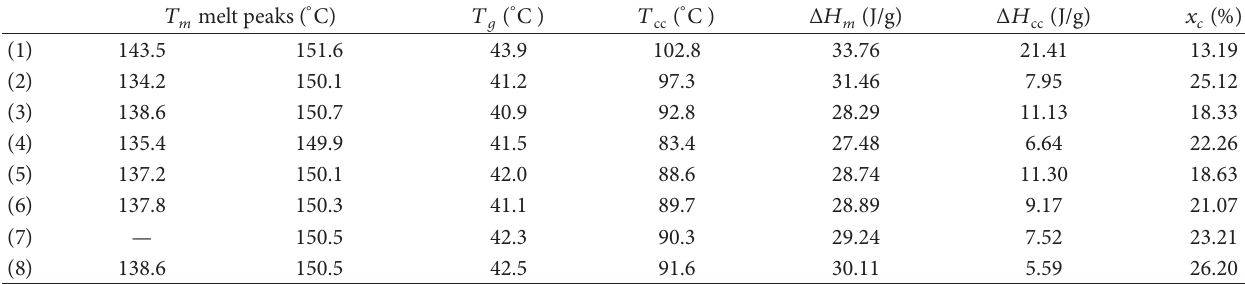
T 2: ermal properties measured by